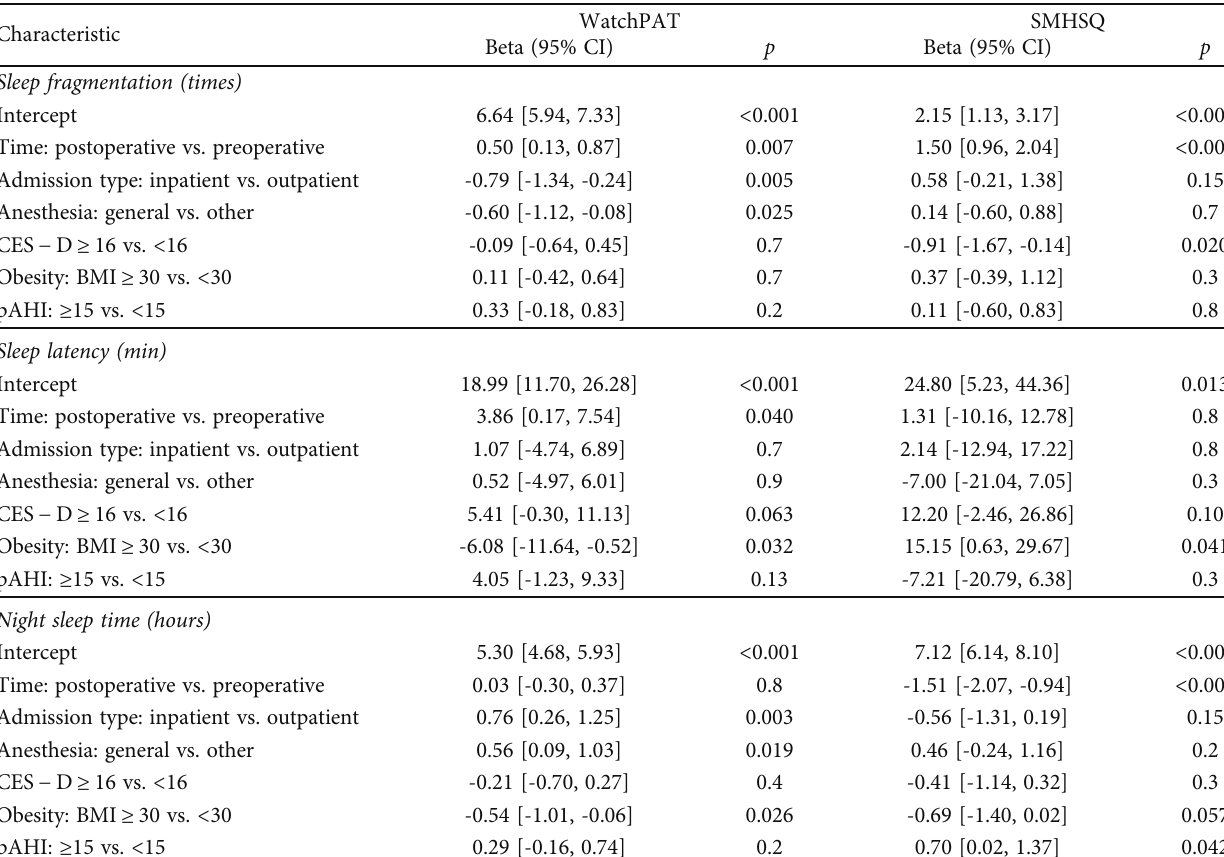
Table 3: Results from the mixed-e ff ects model for sleep fragmentation, sleep latency, and sleep time.